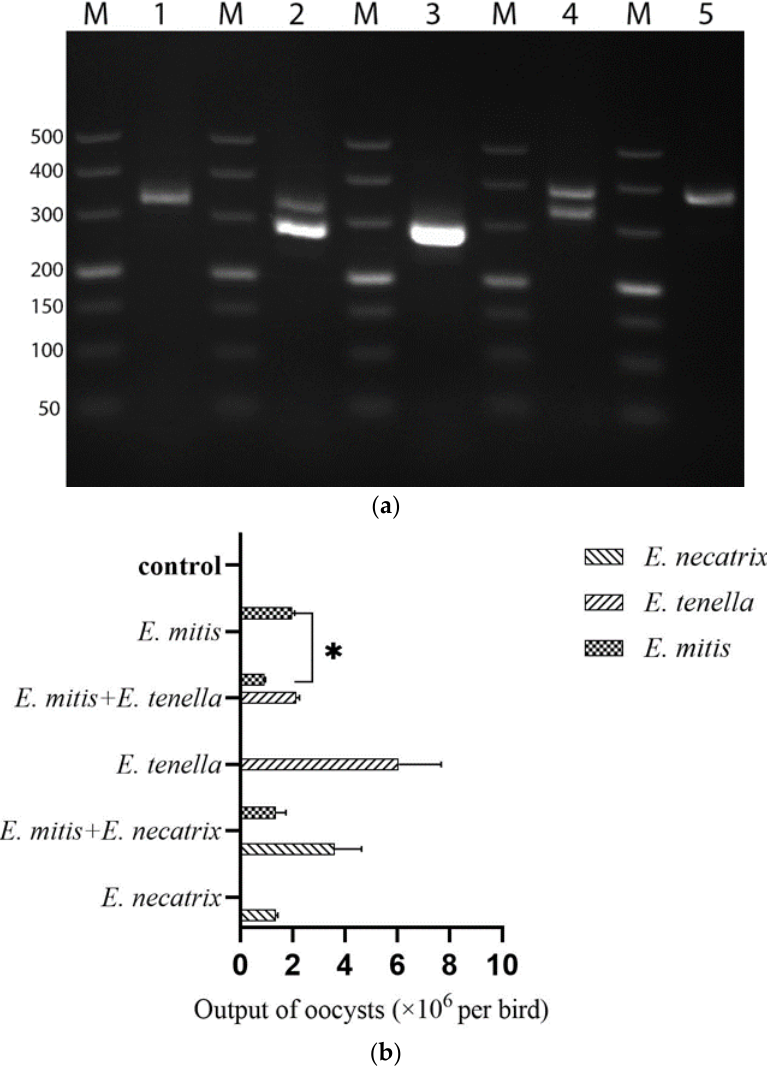
Figure 3. Oocyst shedding in the feces using single and mixed infections of each species. ( a ) Species- specific amplification by PCR assays. Lane M: molecular weight ladder; Lane 1: E. mitis ; Lane 2: E. mitis / E. tenella /; Lane 3: E. tenella ; Lane 4: E. mitis / E. necatrix ; Lane 5: E. necatrix . ( b ) Comparison of oocyst output in single and mixed infection groups. Two groups that differ significantly are marked by a capped line (* p < 0.05).